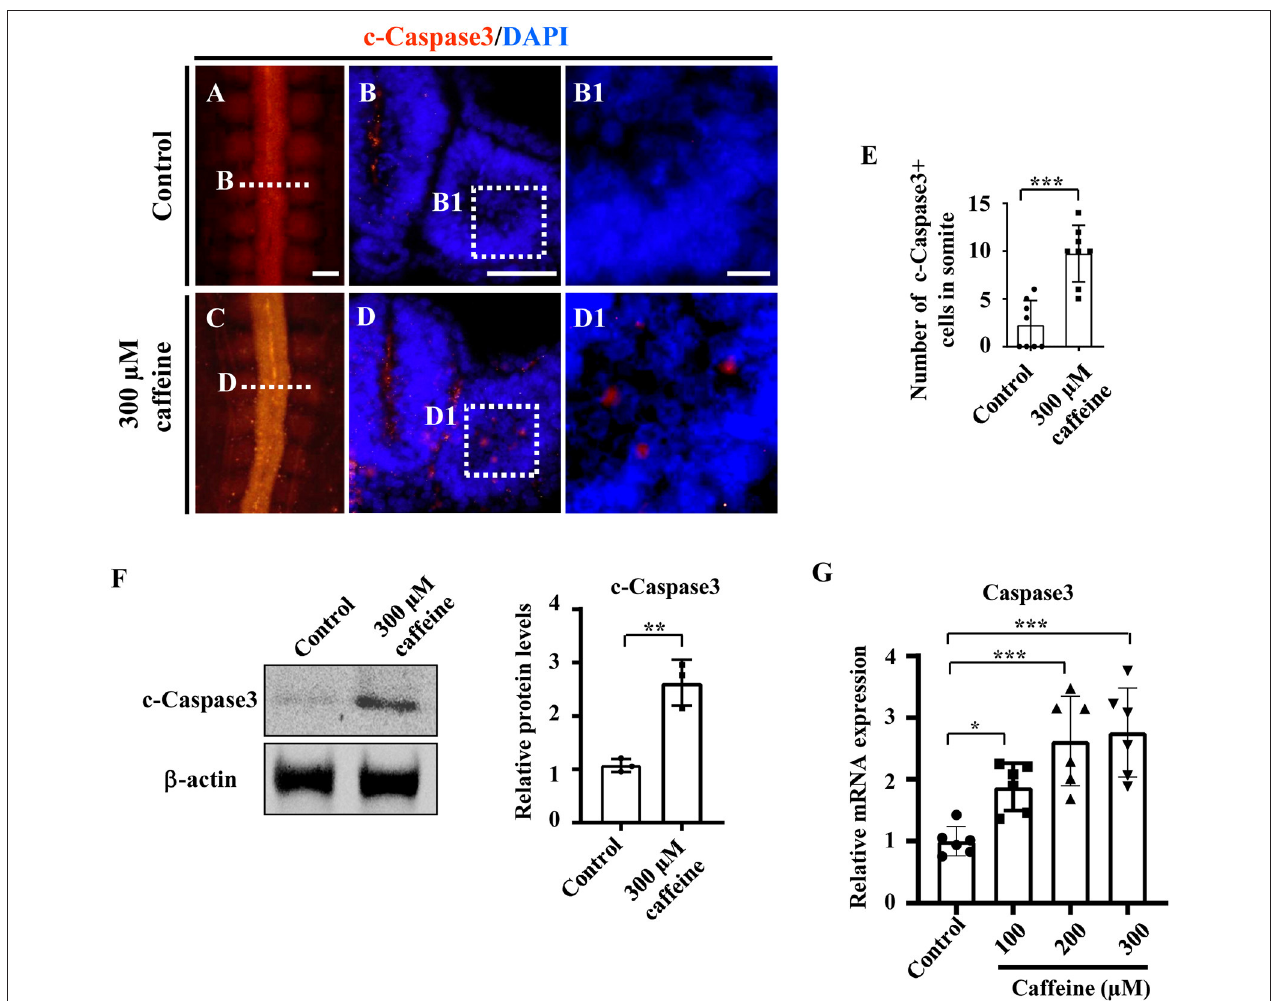
FIGURE 2 | Determination of cell apoptosis in the developing somites of HH10 embryos and C2C12 cells following caffeine treatment. (A–D) Immunofluorescence staining of c-Caspase3 in the chicken embryos from control (A) and caffeine-treated (C) groups, and the corresponding transverse sections for c-Caspase3 and merge with DAPI staining (B,D) . Panels (B/D) is from the fifth pair of somites. (B1,D1) High-magnification images from the sites indicated by (B,D) , respectively. (E) The bar chart showing the proportion of c-Caspase3-positive cell numbers in somite from the control and caffeine-treated groups. c-Caspase3, cleaved Caspase3. (F) Western blotting showing c-Caspase3 expressions in chicken embryos without the head, viscera, and cartilage from the control and caffeine-treated groups. (G) Quantitative RT-PCR data showing the mRNA expression of c-Caspase3 in C2C12 cells after caffeine treatment. Scale bars = 100 µ m in panels (A,C) ; 50 µ m in panels (B,D) ; 10 µ m in panels (B1,D1) . * P < 0.05, ** P < 0.01, *** P <